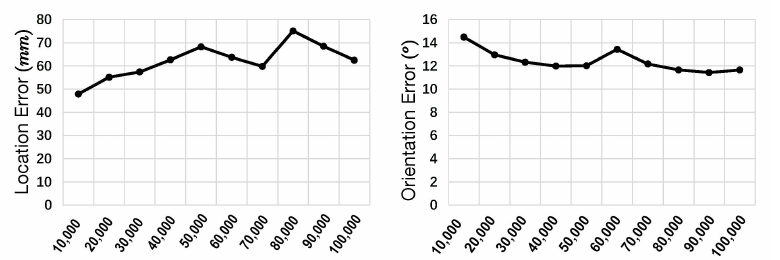
Figure 12. Estimated camera location (mm) and orientation ( ◦ ) errors using different β values (x axis). β = 40,000 was finally selected for our